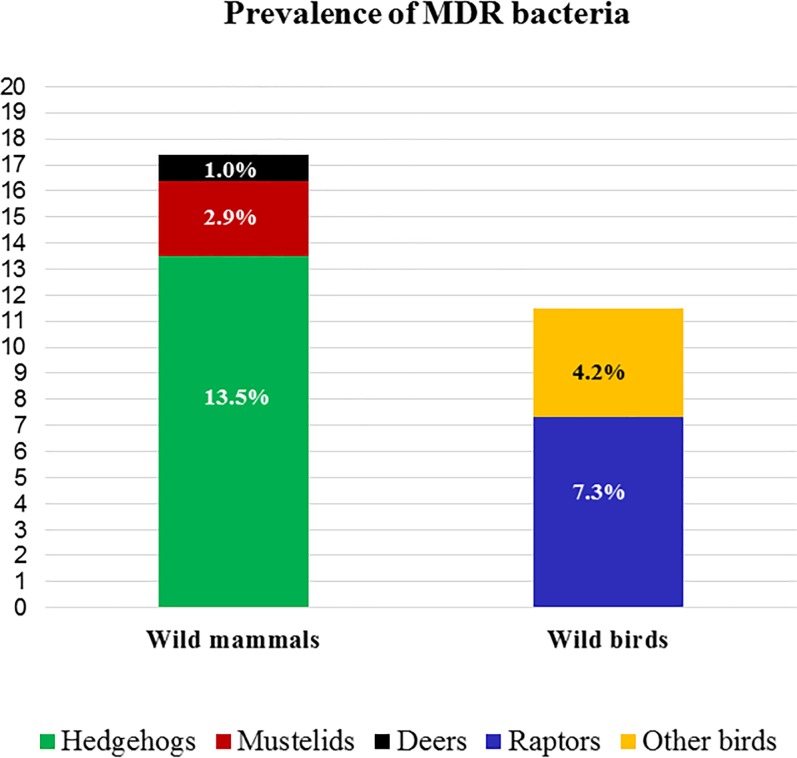
Prevalence of cephalosporin resistant (CR) bacteria in the different wildlife categories.